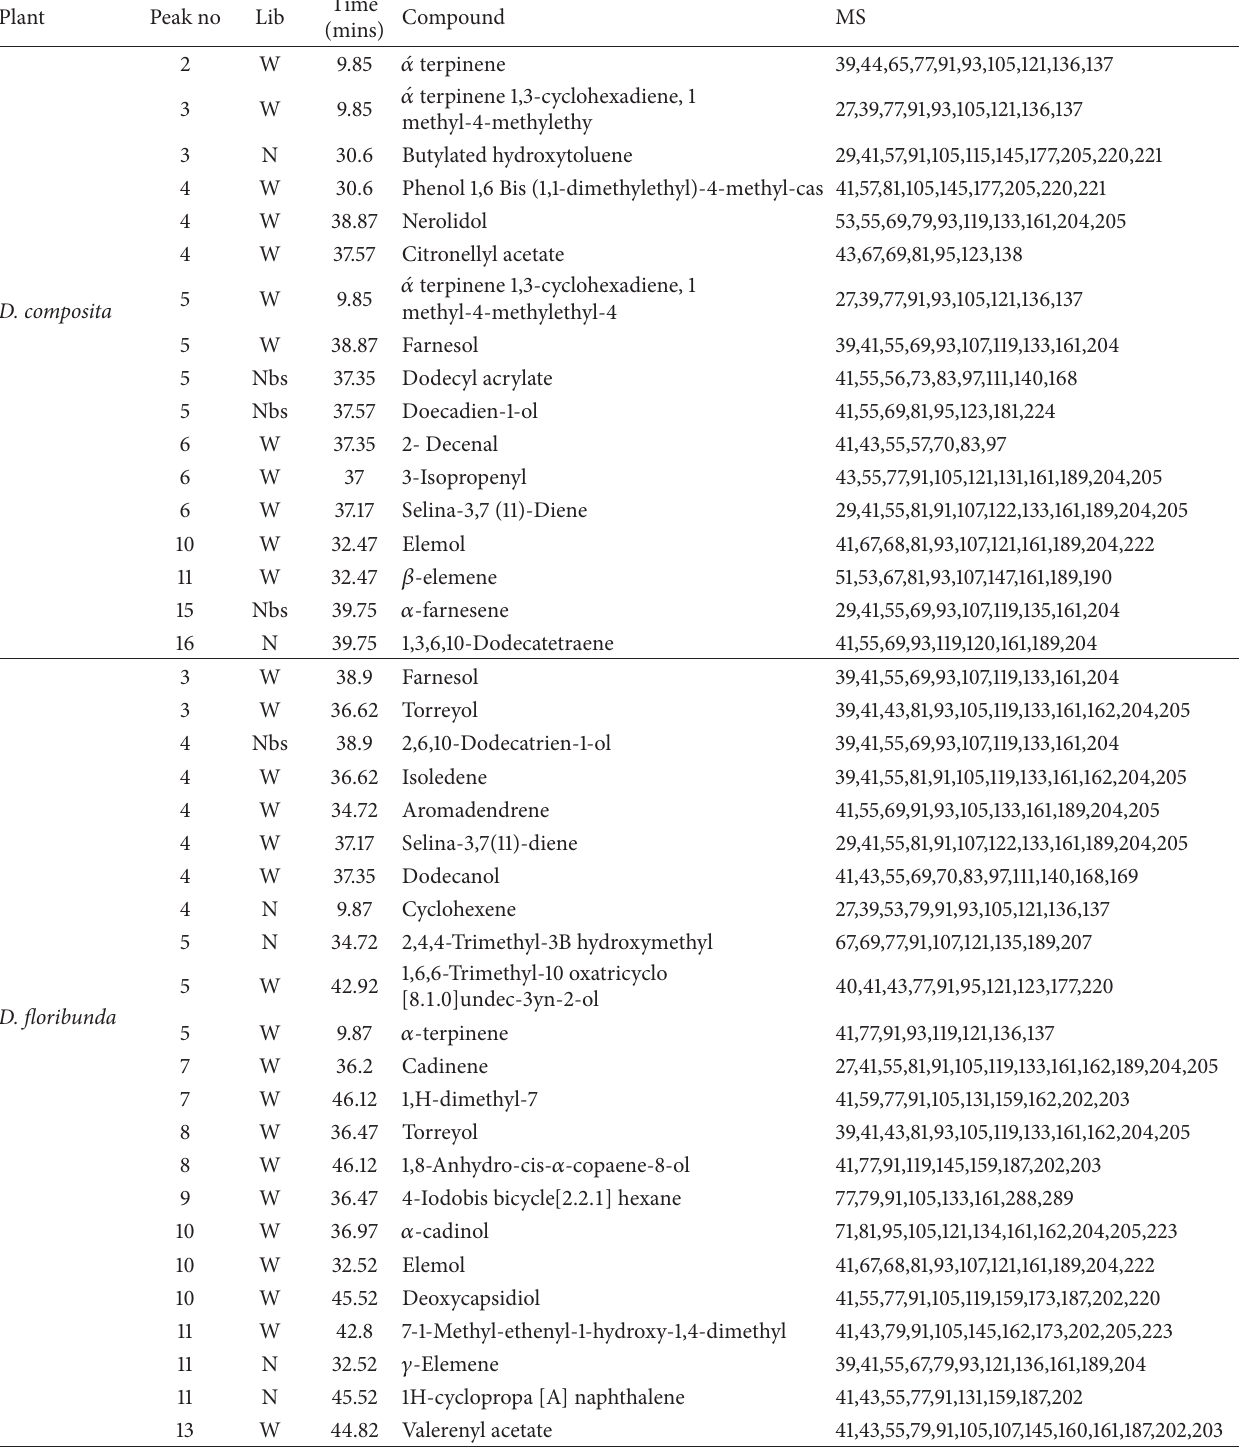
Table1:Majoressentialoilconstituents,theirretentiontime,andMSdatafor Dioscoriacomposita and Dioscoreafloribunda .Differentlibraries such as Wiley, Nbs, and Nist were used for identification of